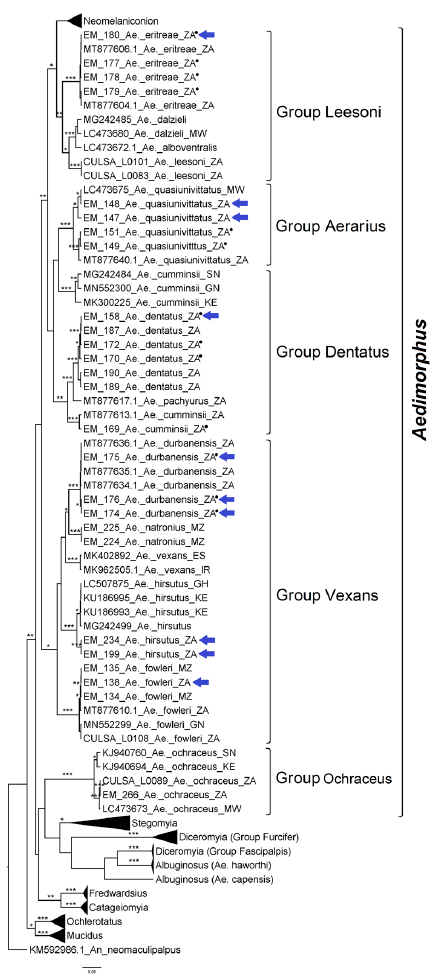
Figure 5. Phylogenetic analysis of 172 partial coxI nucleotide sequences from mosquitoes of the genus Aedes , presenting the subgenus Aedimorphus . At specific branches, the number of * indicates the tree topology support revealed by the different phylogenetic reconstruction methods, assuming relevant bootstrap and aLRT values above 75% and posterior probability values above 0.80. The sequences obtained in this work have the “EM” code and those with associated genitalia are indicated by horizontal blue arrows. The sequences downloaded from GenBank and Boldsystems are indicated by their respective accession numbers and access codes (respectively); the symbol “.” after the code of our sequence indicates that said sequence was not identified by Boldsystems. Their country of origin [South Africa (ZA), Spain (ES), Ghana (GH), Guinea (GN), Iran (IR), Malawi (MW), Mozambique (MZ), Kenya (KE), Senegal (SN)] are also indicated. The vertical lines mark the informal groups and the subgenus Aedimorphus ; the collapsed branches are the species of the subgenera and/or informal groups of the